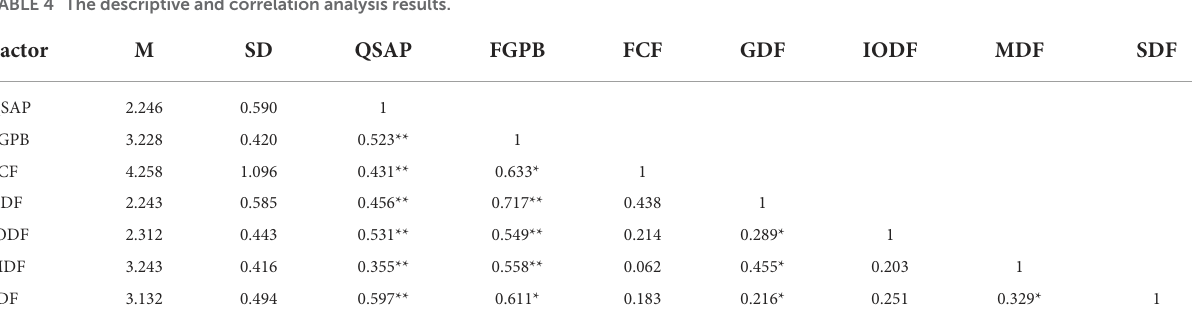
TABLE 4 The descriptive and correlation analysis